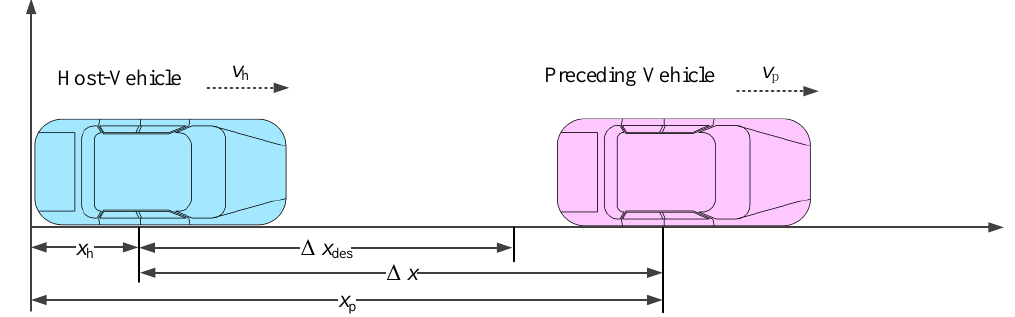
Figure 19. Vehicle longitudinal kinematics model.